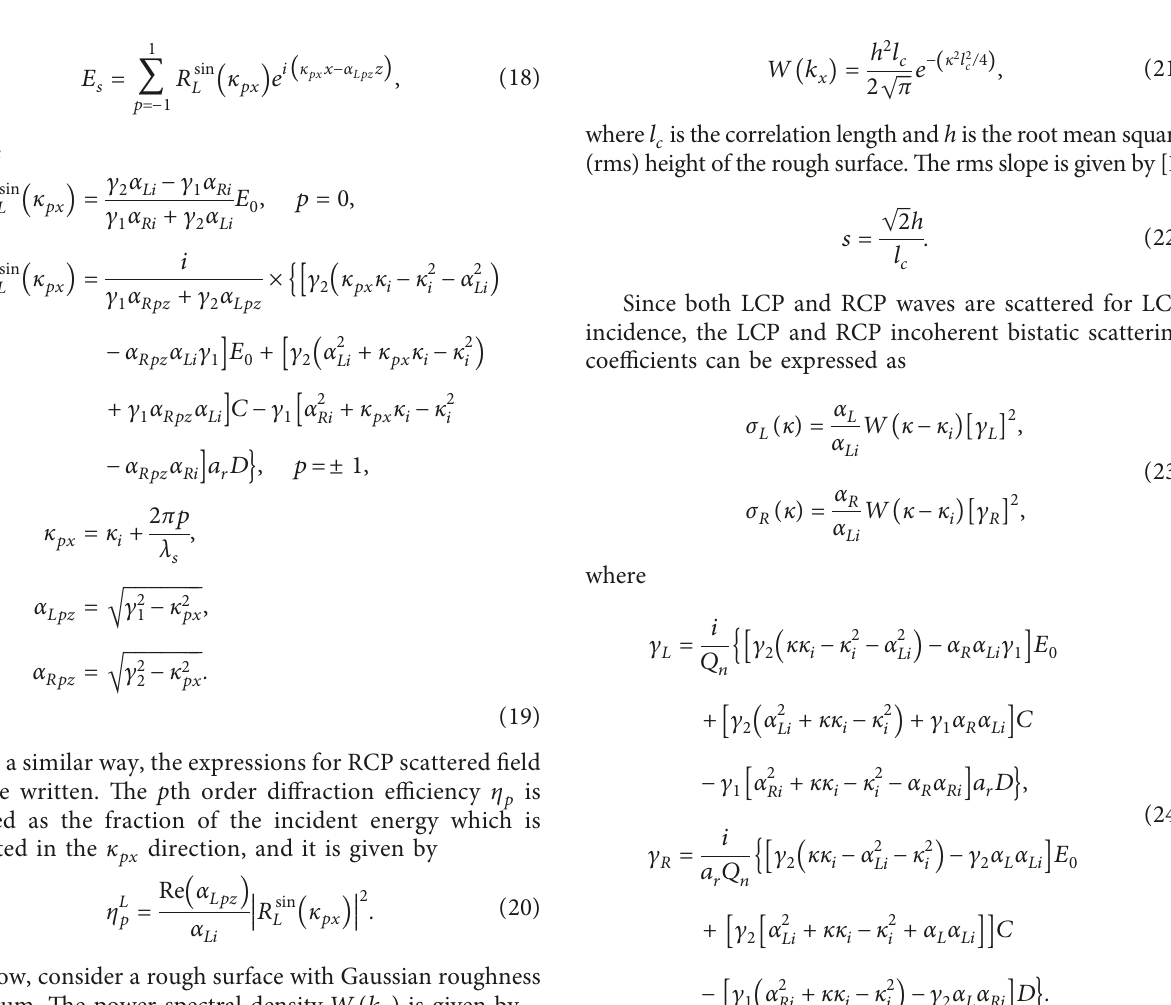
° , ε i (cid:31) 30 r (cid:31) 4, β (cid:31) 0.03, and h (cid:31)